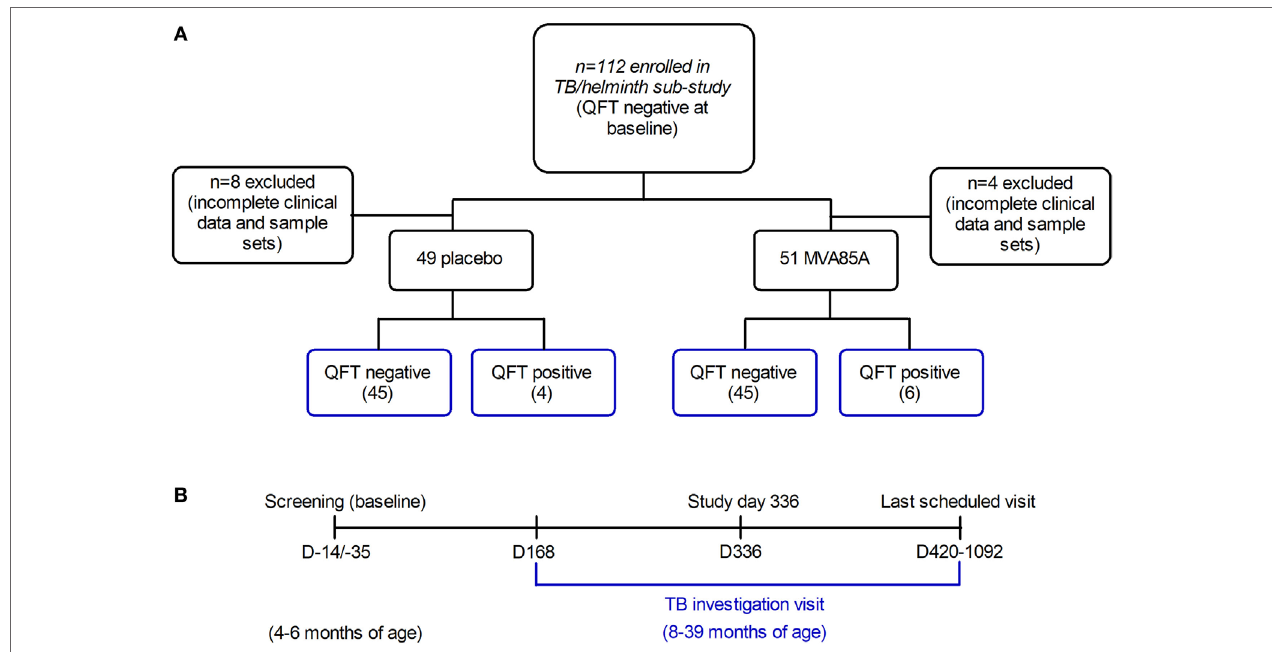
FigUre 1 | Infants recruited to the tuberculosis (TB)/helminth study. Infants enrolled in the MVA85A trial were randomly assigned to the placebo or MVA85A vaccination arms (a) . 112 infants were recruited to the TB/helminth study; incomplete clinical data and sample sets were available for n = 12 infants, leaving n = 100 available for further analysis. Time-points of blood collection for QFT (QuantiFERON) (B) were at baseline, study day 336, at last scheduled visit and/or upon TB investigation. Per participant, serum was analyzed at baseline and upon TB investigation. The age range of infants at baseline was 4–6 months, and the age range at TB investigation was 8–39